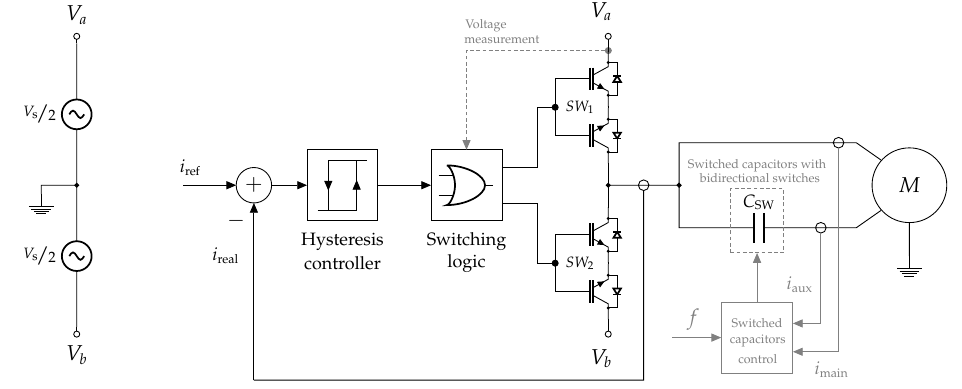
Figure 19. Matrix converter with an active induction motor